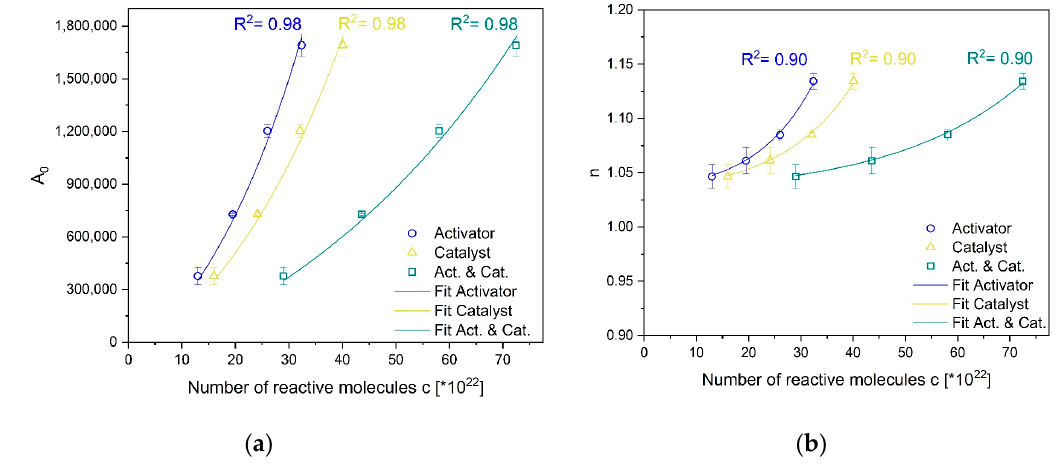
Figure 4. Fits of the coefficients A 0 ( a ) and n ( b ) with the number of reactive molecules